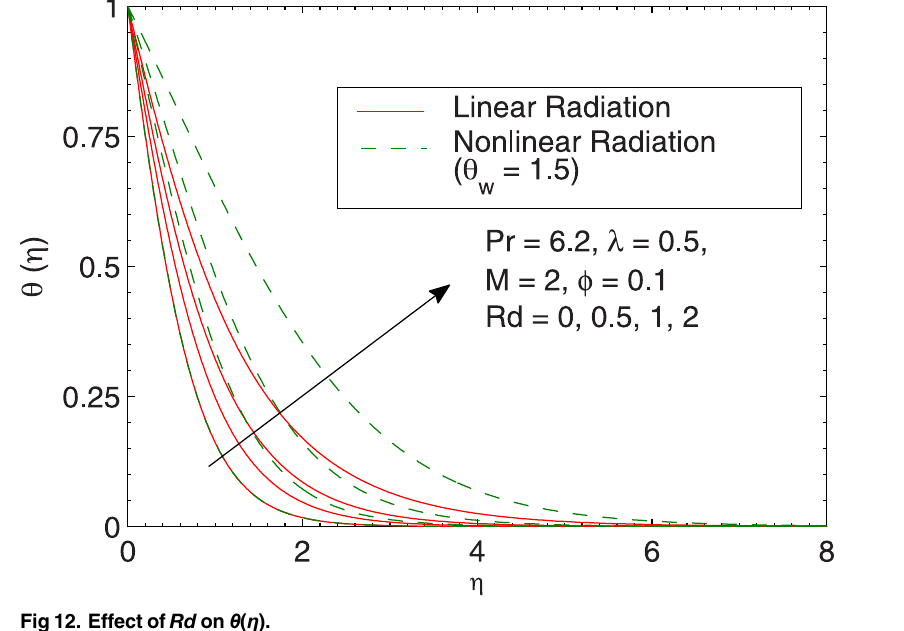
Fig 12. Effect of Rd on θ ( η